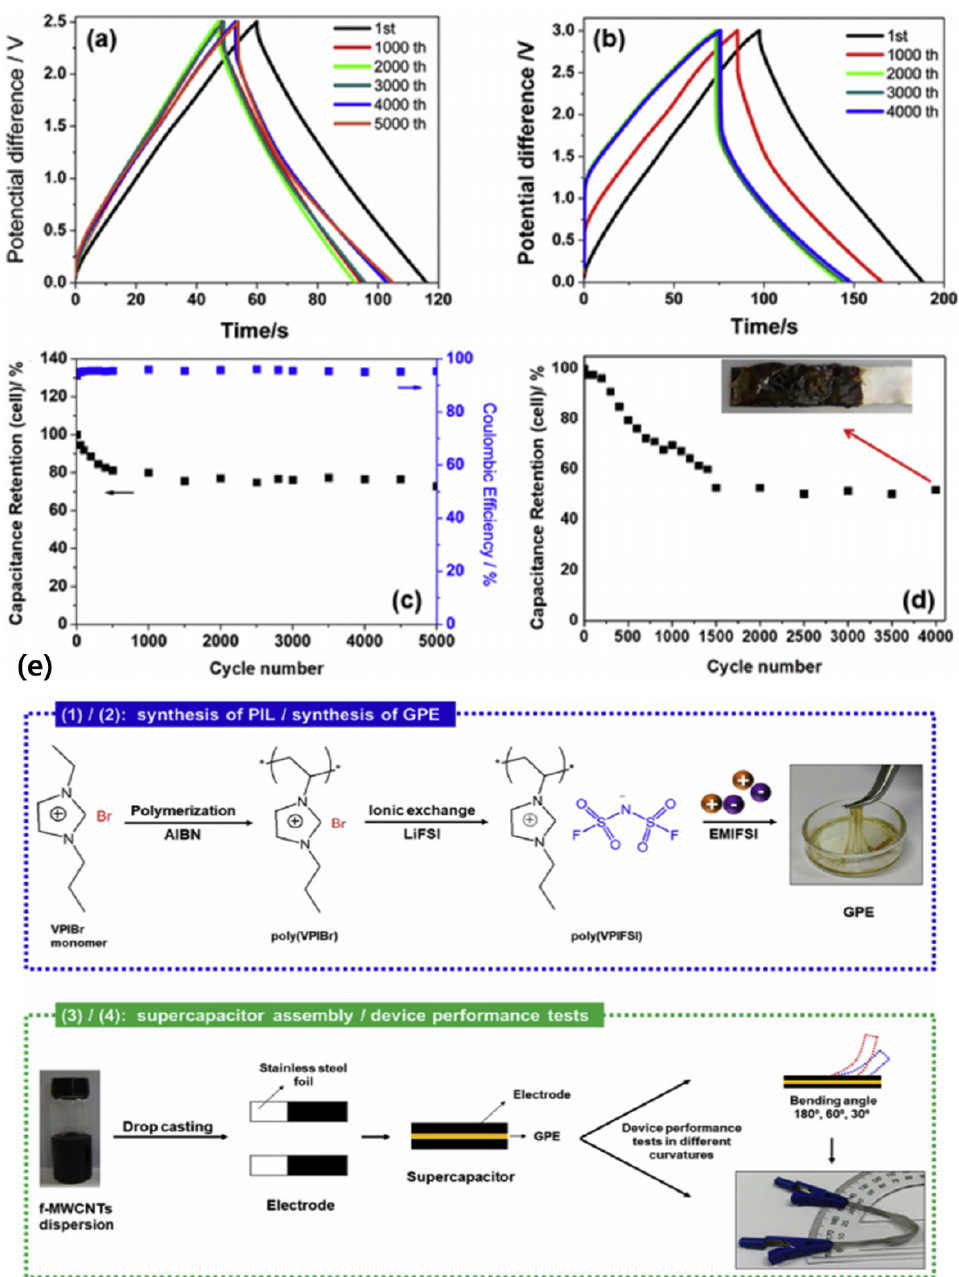
Figure 18. Galvanostatic charge–discharge profile for the SCs at 0.5 A g − 1 at ( a ) 2.5 V; ( b ) 3.0 V. The cycle stability at ( c ) 2.5 V; ( d ) 3.0 V. ( e ) Schematic illustration of the experimental procedures. Reprinted 2019 from [153] with permission from Elsevier. Reprinted 2019 from [152] with permission from